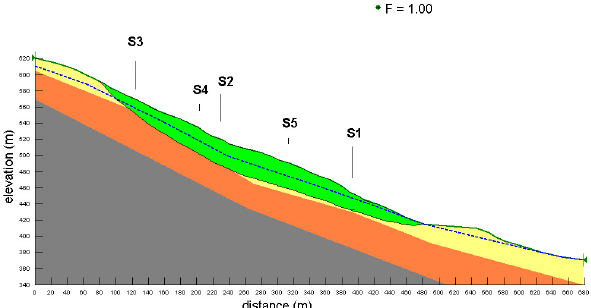
Fig. 13. San Rocco landslide: assumed water table geometry for